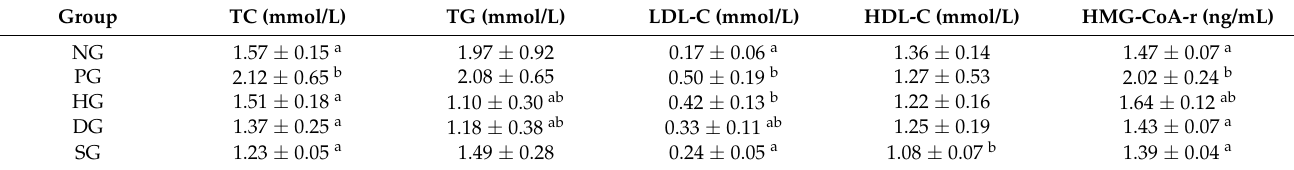
TC, total cholesterol; TG, triglyceride; LDL-C: low-density lipoprotein cholesterol; HDL-C: high-density lipoprotein cholesterol; HMG- CoA-r: 3-hydroxy-3-methyl-glutaryl-CoA reductase; NG, normal rats group; PG, hypercholesterolemic positive control rats group; HG, hypercholesterolemic rats treated with 2 % DPO; DG, hypercholesterolemic rats treated with 2 % DDP; SG, hypercholesterolemic rats treated with 10 mg/kg simvastatin. a Indicates a statistically significant difference ( p < 0.05) versus PG group; b indicates a statistically significant difference ( p < 0.05) versus NG group by Duncan’s multiple range tests using SPSS for windows version 23. Results are given as man ± SD ( n =